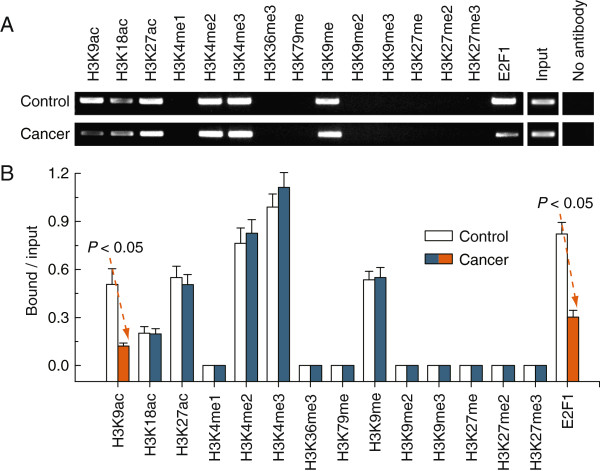
Comparative analysis of histone modification and E2F1 enrichment around the E2F1 motif between BRCA1-mutated breast cancer and adjacent normal breast tissues. A, chromatin immunoprecipitation was performed using antibodies to H3K9Ac, H3K18Ac, H3K27Ac, H3K4me1, H3K4me2, H3K4me3, H3K36me3, H3K79me, H3K9me, H3K9me2, H3K9me3, H3K27me, H3K27me2, H3K27me3 and E2F1. PCR was performed for regions within the CpG islands and around the E2F1 motif. A negative control without antibodies is included for comparison. B, representative results of 15 primary BRCA1-mutated breast cancer and their normal breast tissues are shown. Bar graphs show mean ± SD.